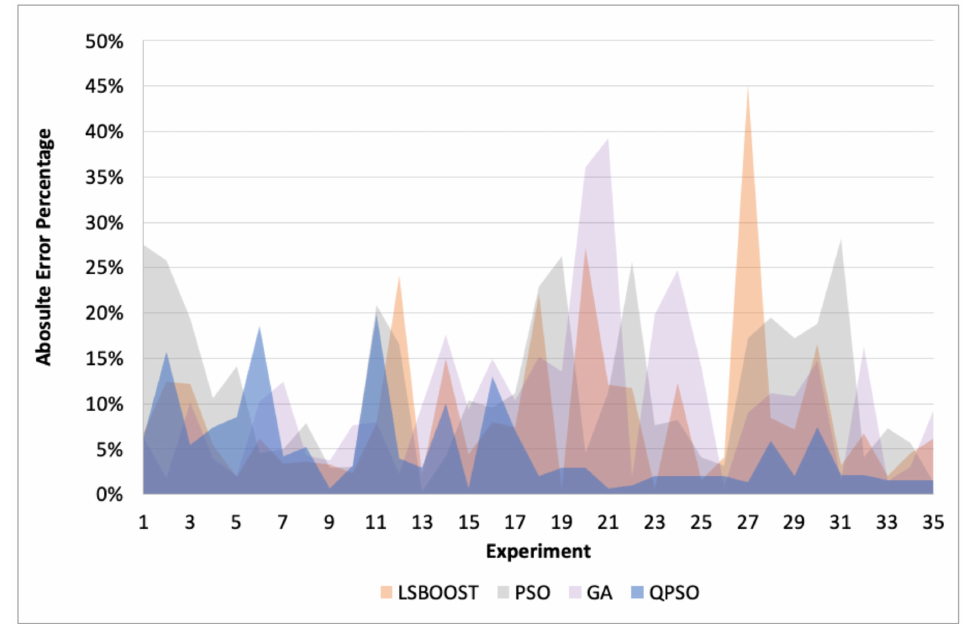
Figure 3. Absolute error percentage of each data point predicted by QPSO, LSBoost, PSO and GA